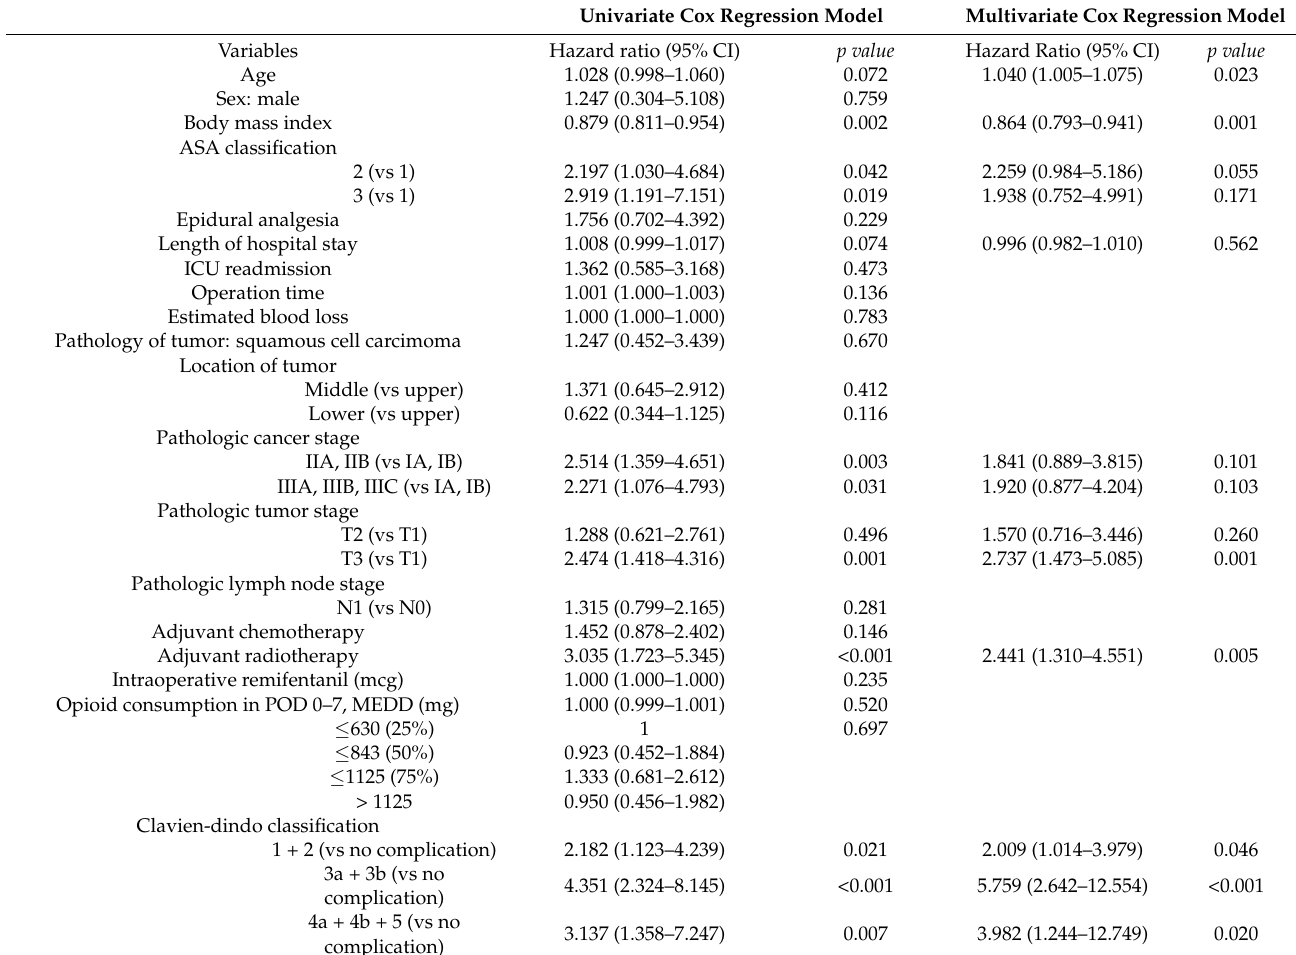
Table 2. Univariate and multivariate cox regression analysis for overall survival in esophageal cancer patients. Univariate Cox Regression